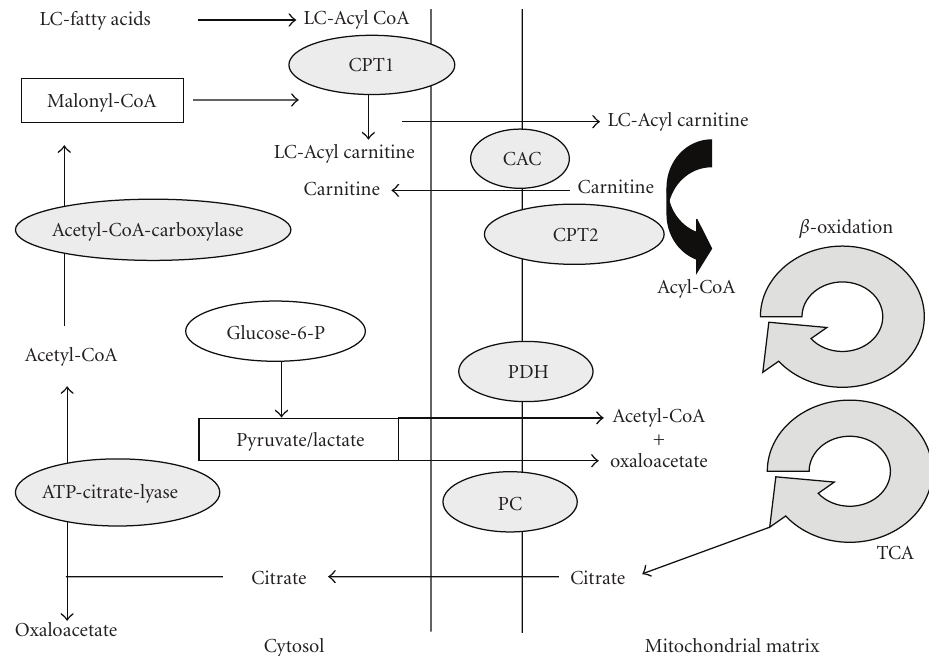
Figure 2: llustration of biochemical interactions: the carnitine shuttle, fatty acid oxidation, and glycolysis. The mitochondrial membrane is not permeable to long-chain fatty acids. The carnitine shuttle has to be used to transfer long-chain fatty acids to the mitochondrial matrix space. Once in the mitochondrial matrix space, long-chain acylcarnitines are converted back to long-chain acyl-coenzyme A derivatives and free carnitine via CPT2. Free carnitine is released and the acyl-coenzyme A derivatives will enter the beta-oxidation pathway. CPT1: Carnitine-Palmitoyltransferase 1; CPT2: Carnitine-Palmitoyltransferase 2; CAT: Carnitine-/Acylcarnitine-Transferase; LC: Long-chain;